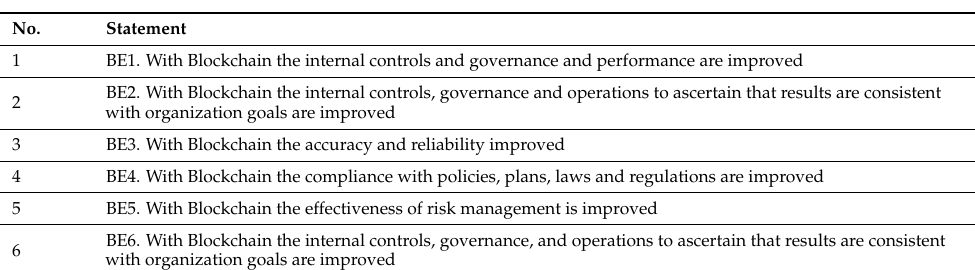
Table 3. List of statements on blockchain perceived effectiveness (Source: authors’ compilation). I. Dependent Variable Blockchain